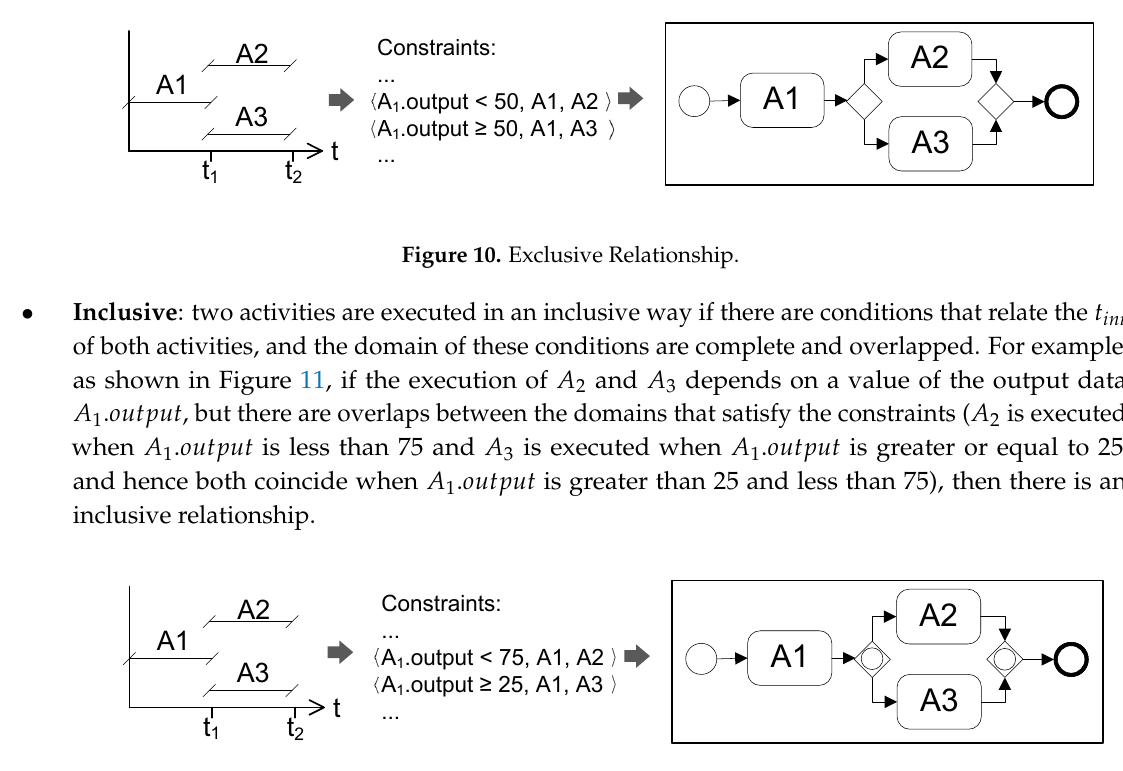
Figure 11. Inclusive